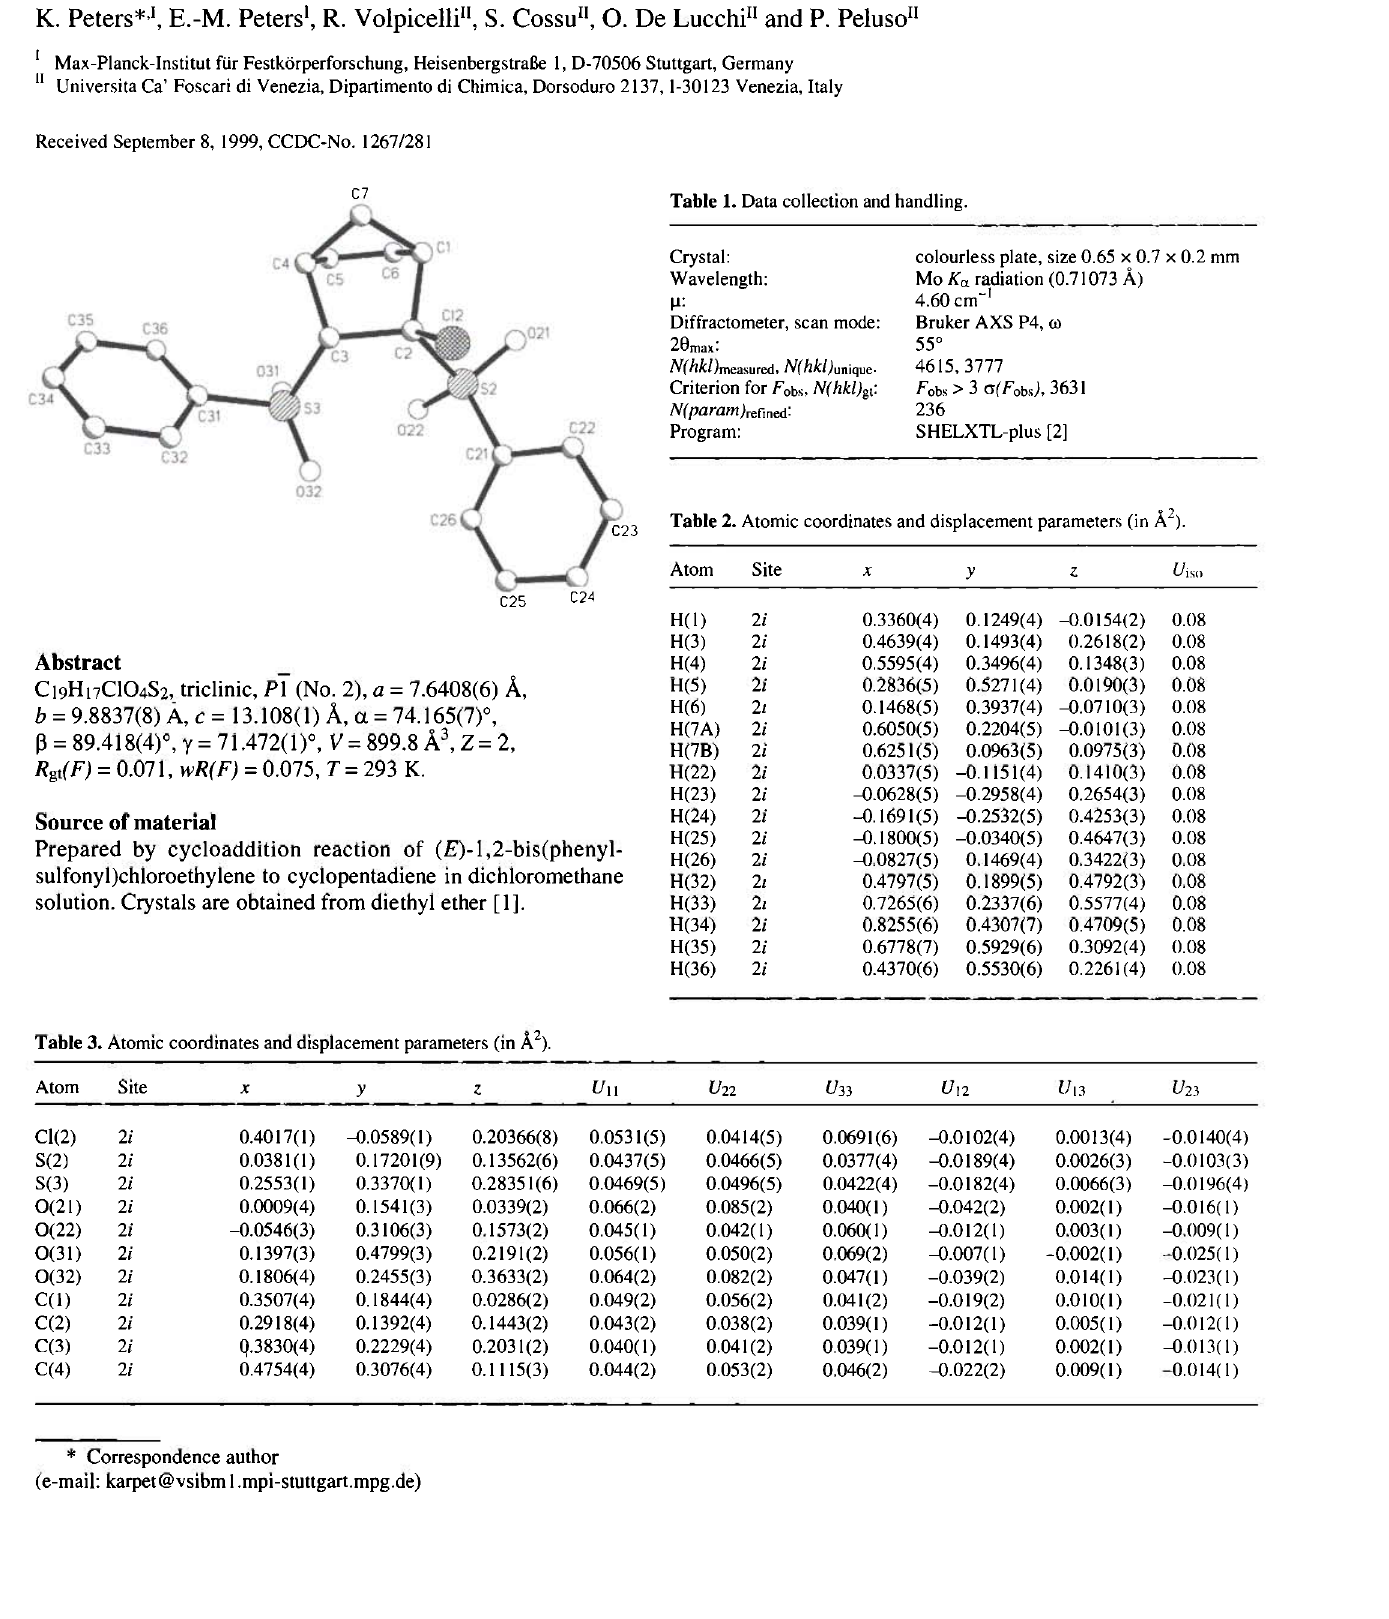
Table 1. Data collection and handling.